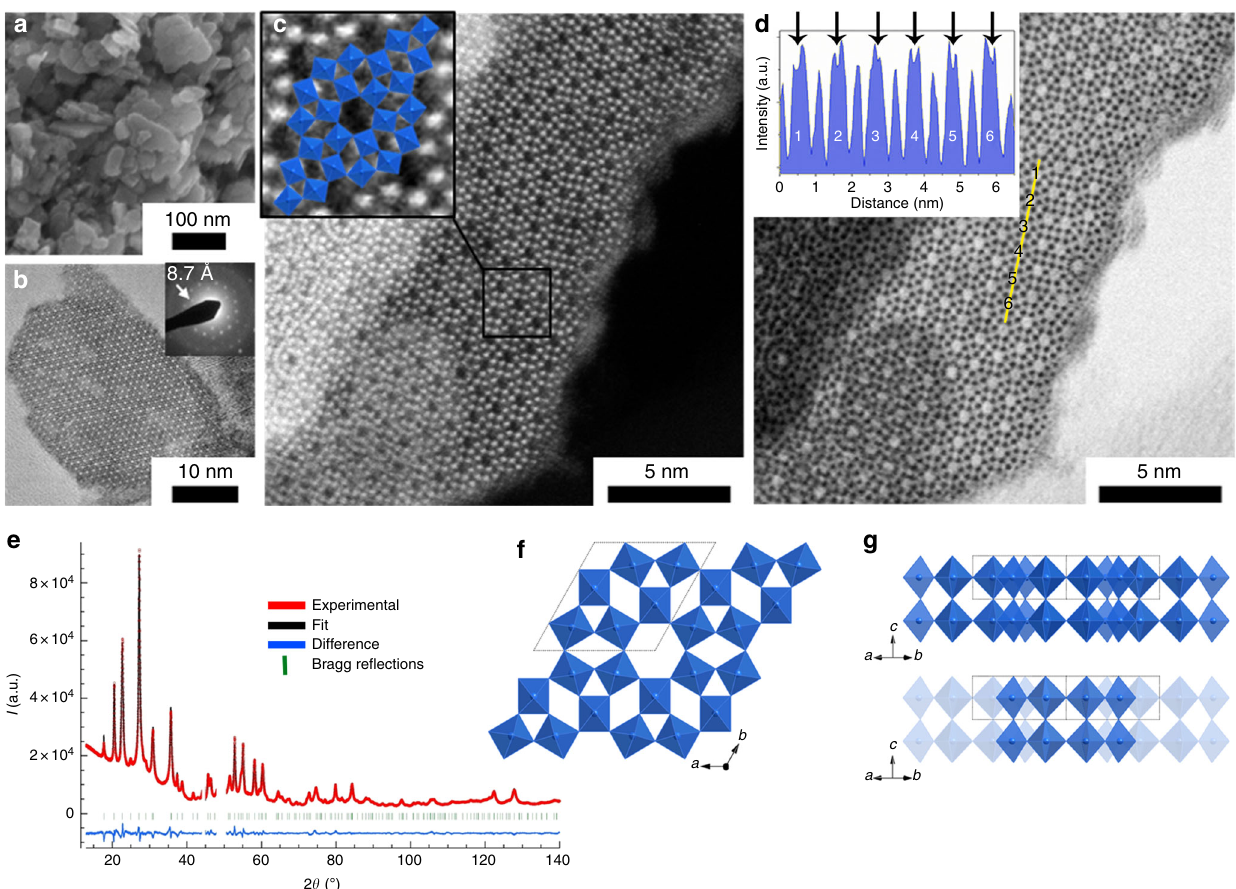
Fig. 1 Structure and nanostructure of the h ’ -WO 3 framework. The study has been performed on the bronze recovered directly after aqueous synthesis. a SEM and b HRTEM images showing nanosized platelets. The inset in ( b ) shows a typical hexagonal SAED pattern. c HAADF-STEM and d corresponding ABF-STEM micrographs showing the arrangement of tungsten octahedra (blue, in inset of ( c )). e Rietveld re fi ned powder XRD pattern (Cu K α ). Projections of the structure along the ( f ) c axis and ( g ) the [110] direction. Bottom of ( g ) shows the structure with depth fading to highlight square channels along the [110] direction. The inset in ( d ) shows contrast variations along the yellow line. Each large increase in intensity corresponds to each numbered (WO 6 ) 6 tunnel along the line. Black arrows show depressions of intensity in each tunnel, highlighting inserted